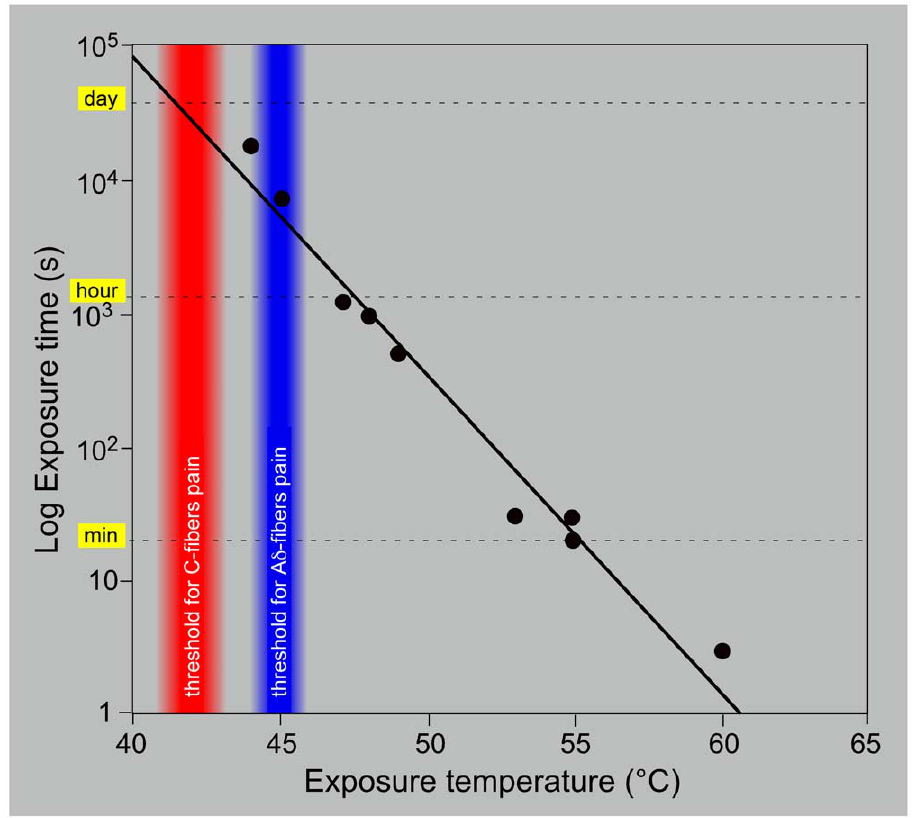
Figure 11. Time-surface temperature thresholds for thermal injury of Human skin. Relationship between exposure time (s) and skin surface temperature ( u C) according to data from Moritz & Henriques [74]. The solid line indicates the limit between absence of a thermal lesion and a first superficial degree of skin burn (hyperemic reaction). Data related to the hand from table 2 are added as red (threshold for C-fibers pain) and blue (threshold for A d -fibers pain) areas.